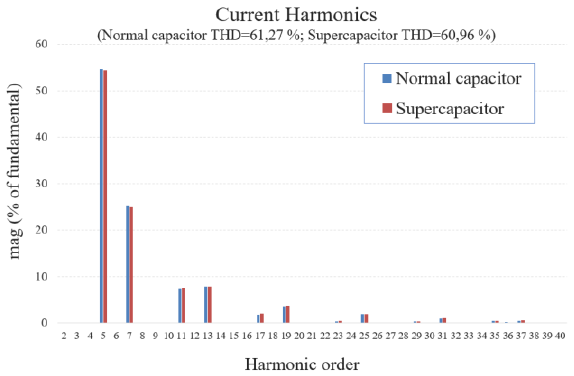
Figure 3. Input current harmonics